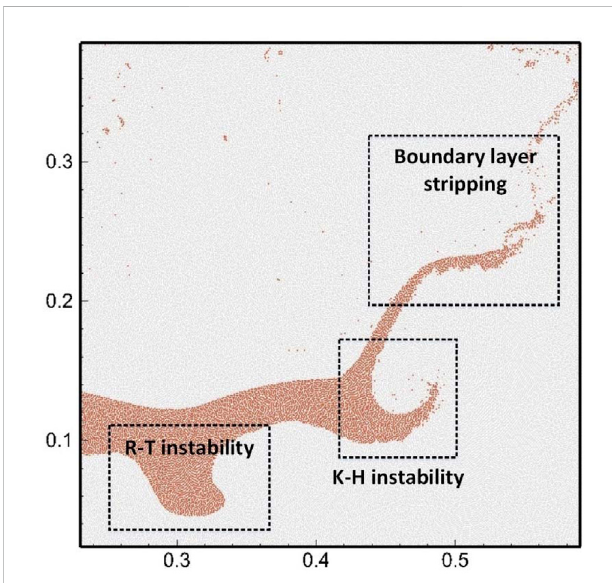
FIGURE 13 Local magni fi cation in U-Na interaction at t = 0.57